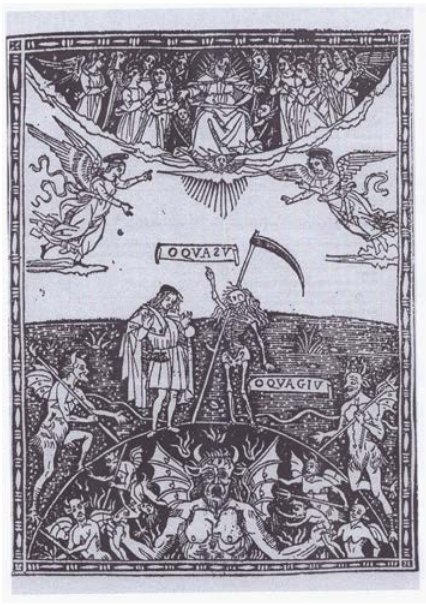
Figure 5 – Girolamo Savonarola, Predica dell’arte del Bene morire , s.n.t. [but Firenze, Bartolomeo de’ Libri, after november 2, 1496), f. 6v (BNCF, Cust. E 6). By permission of Ministero per i beni e le attività culturali / Biblioteca Nazionale Centrale.